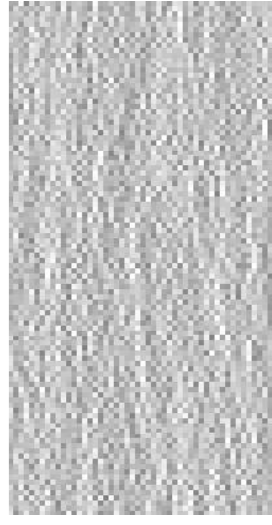
Figure 5. Initial model of coal sample containing gas.